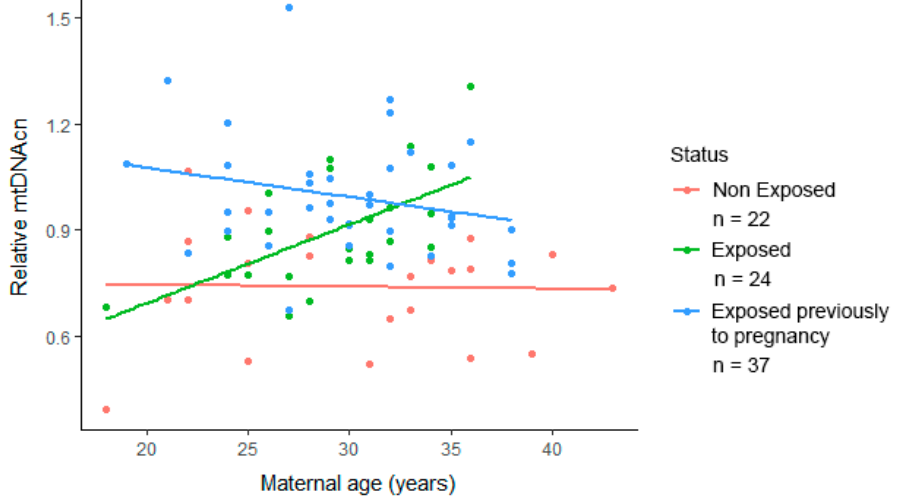
Figure 2. Maternal age as an effect modifier in the adjusted association between earthquake expo- sure during pregnancy and mtDNAcn, p < 0.05. Data are presented in a scatter plot with a linear regression by study